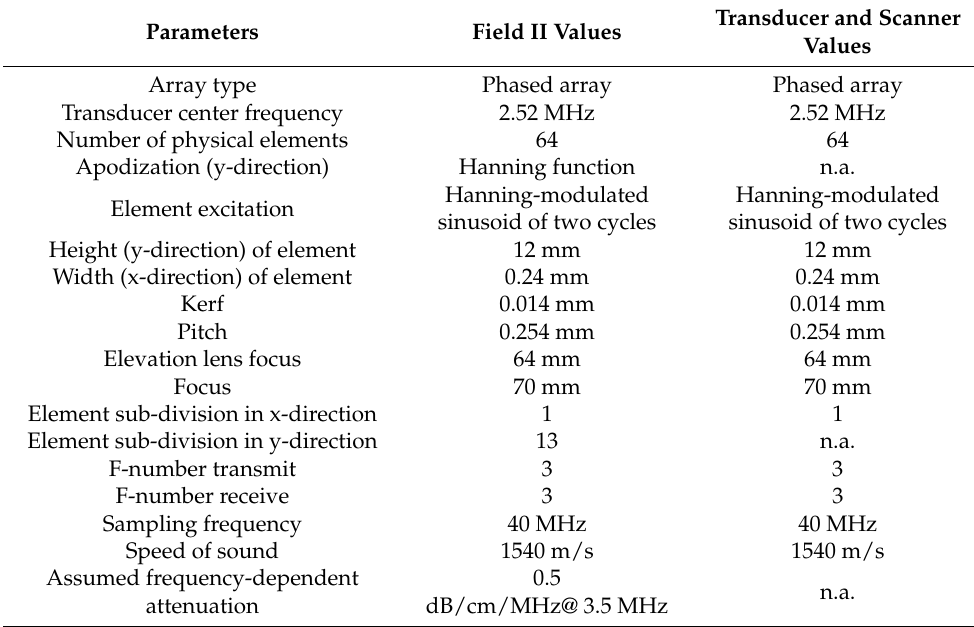
Table 1. Parameters of virtual scanning with Field II and settings of transducer and scanner for wire, contrast, and slice thickness phantoms.